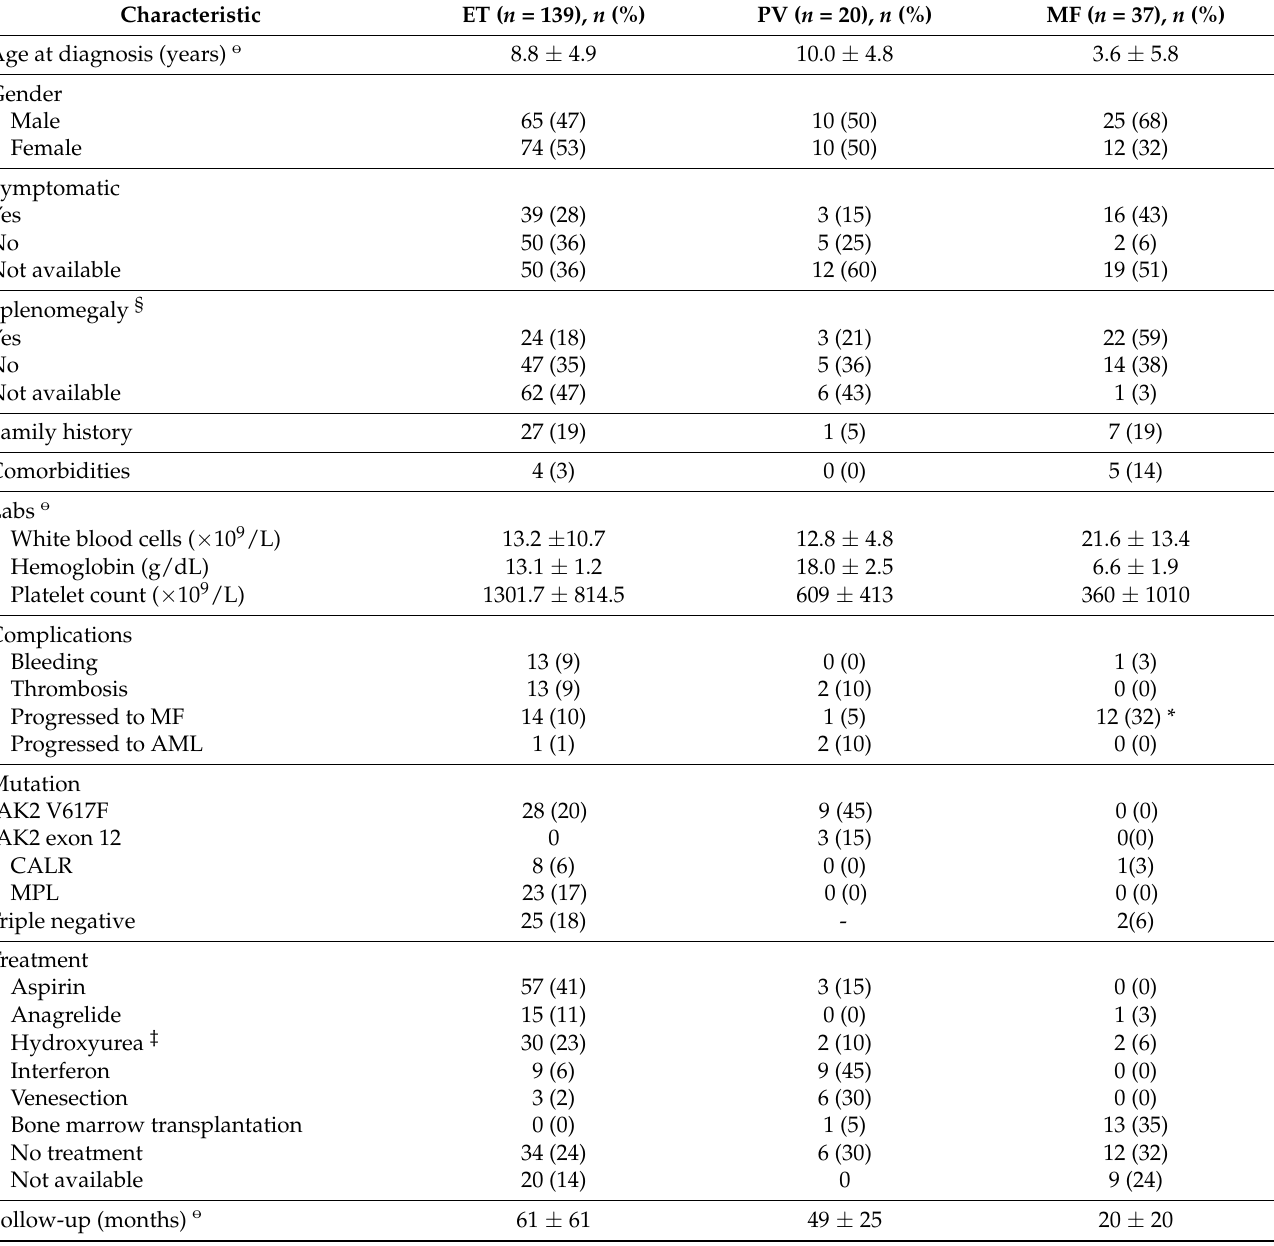
Table 2. Characteristics, outcomes, and treatment of patients with essential thrombocythemia, polycythemia vera, and